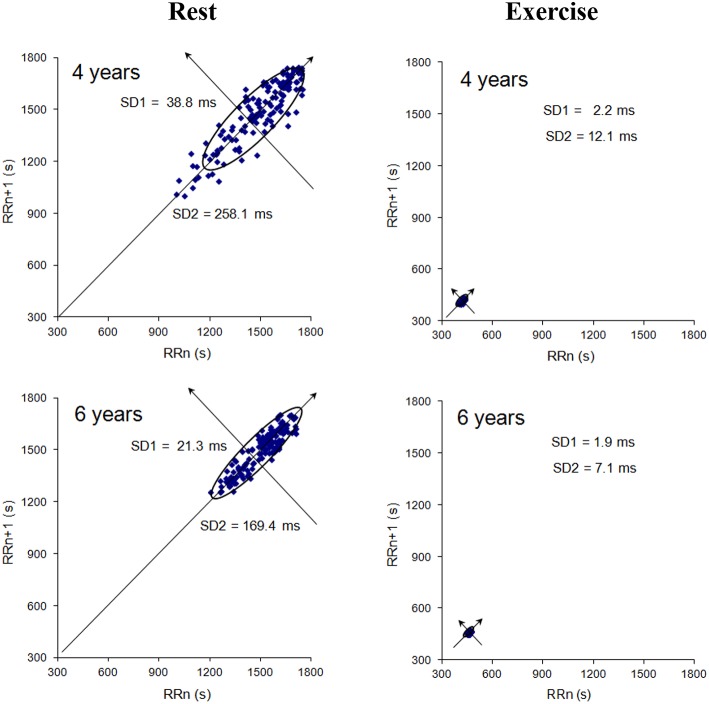
Typical examples of Poincaré plots at rest and during exercise (for a 4-year-old in the top panel and a 6-year-old in the bottom panel). SD1 (the standard deviation of instantaneous variability) and SD2 (the standard deviation of continuous variability) are indicated on each plot. SD1 (RMSSD2) is lower in the 4-year-old than in the 6-year-old (p < 0.05).